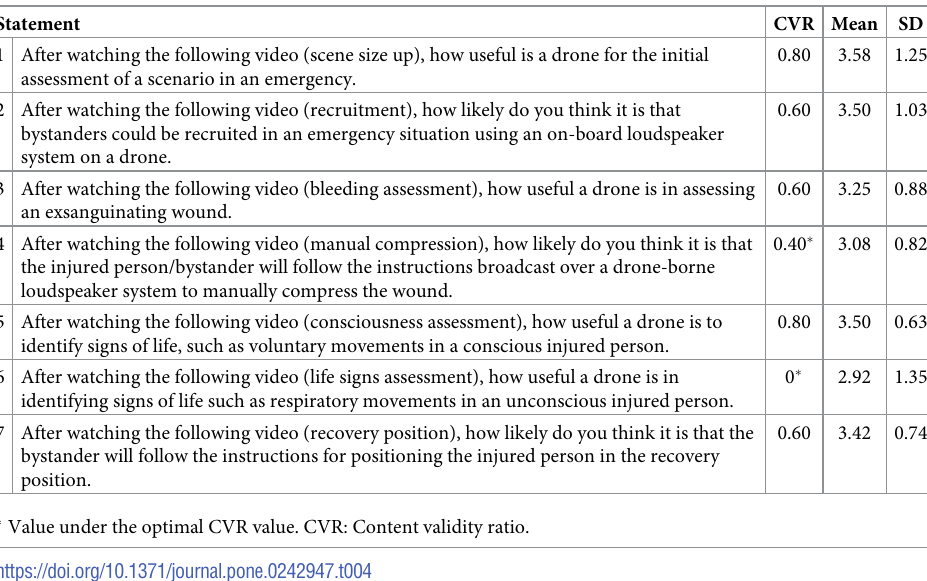
Table 4. Content evaluation of statements about image